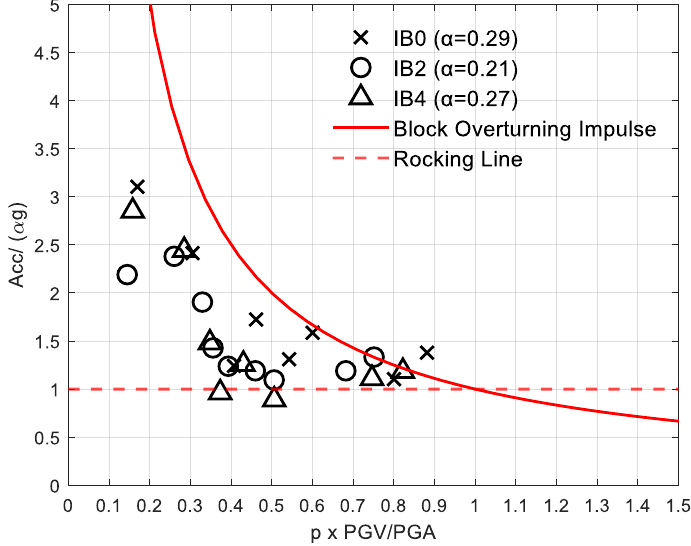
Figure 10. Comparison of the experimentally observed Peak Ground Acceleration (PGA) in plots a,